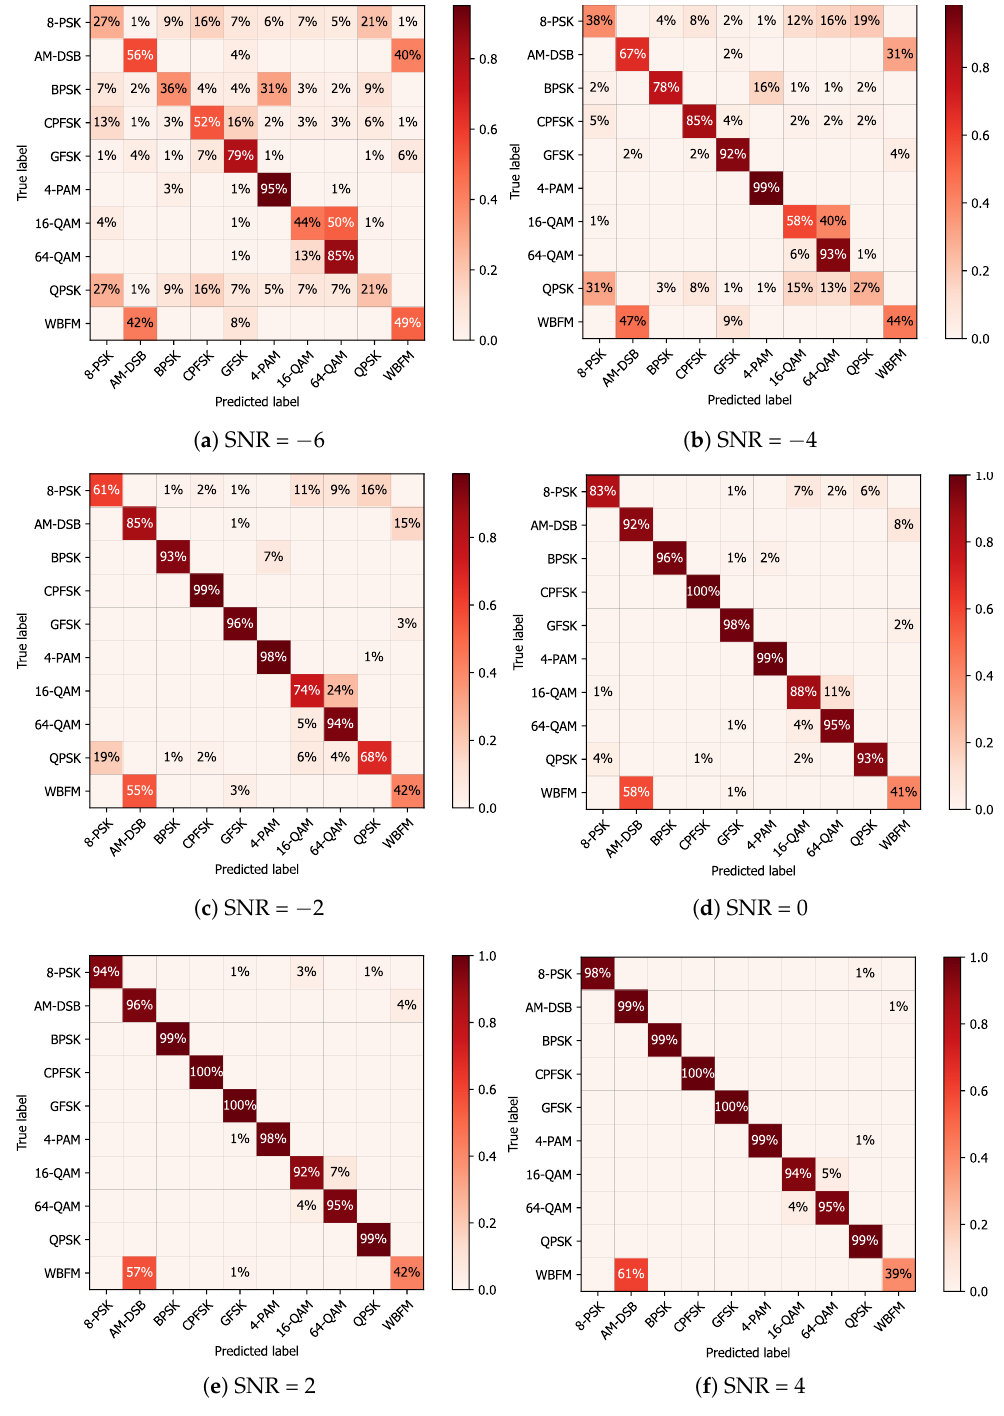
Figure 11. Confusion matrix under different